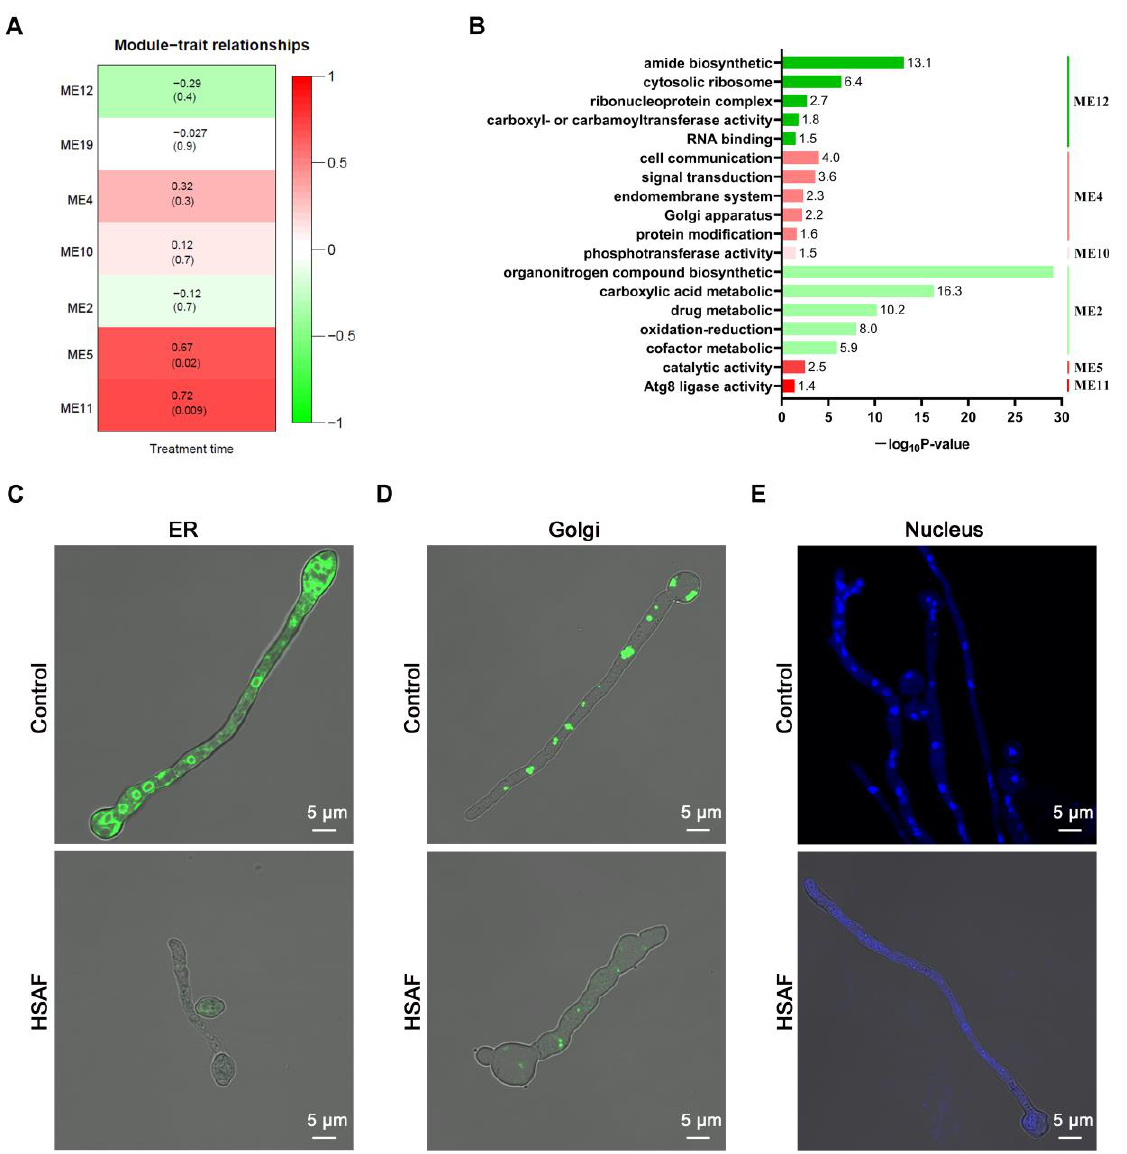
Figure 6. HSAF treatment may trigger autophagy-mediated degradation in N. crassa . ( A ) Correlation heat map of Modules and HSAF; ( B ) Functional category of DEGs in different modules; ( C ) Confocal microscopy of cellular morphology from germlings containing sGFP-tagged NCA-1 (ER marker); ( D ) Confocal microscopy of cellular morphology from germlings containing sGFP-tagged VRG-4 (Golgi marker); ( E ) Confocal microscopy of cellular morphology from germlings stained with DAPI. The germlings were grown in Vogel’s medium supplemented with 30 µ M HSAF for 5 h. Images show the results of one out of three replicates.